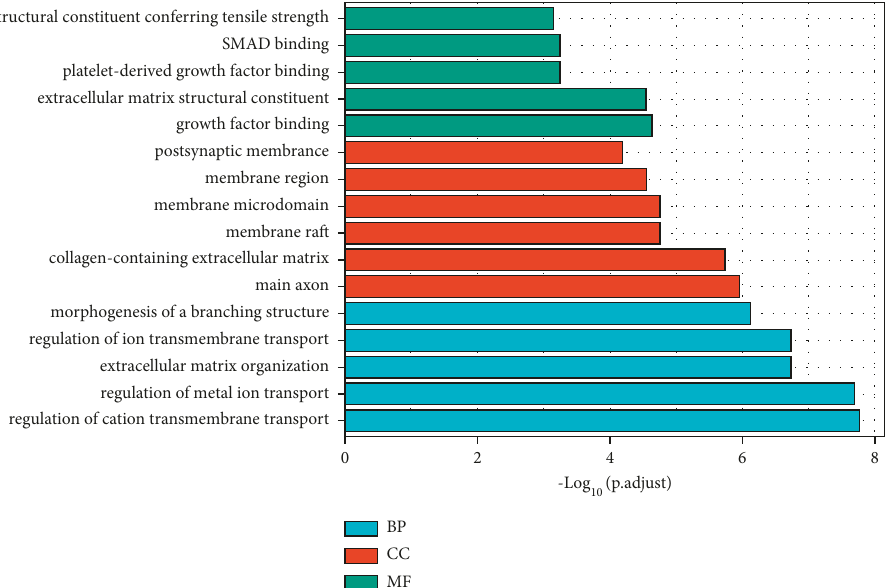
Figure 7: GO analysis of miR-149-3p target genes.